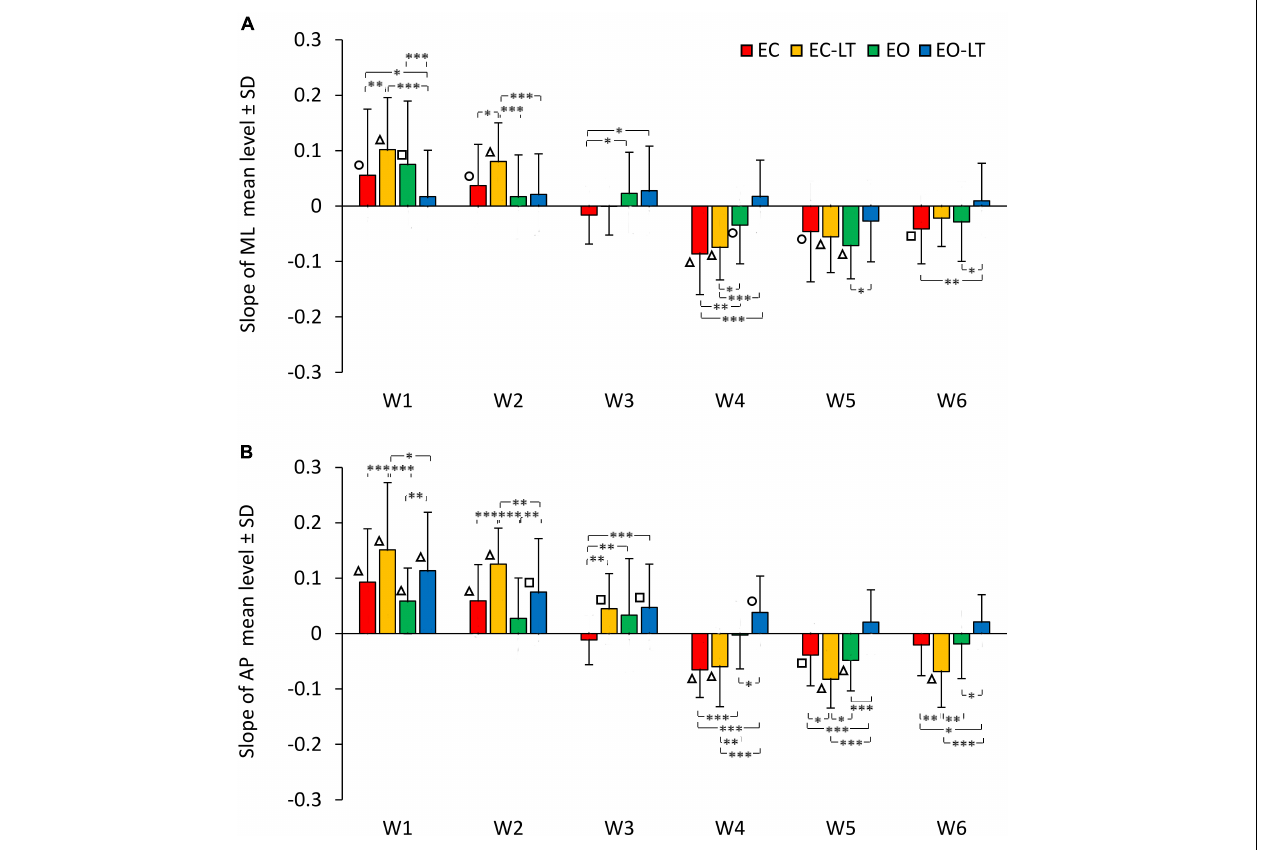
FIGURE 6 | Adaptation rate in the frequency windows (Ws) of ML (A) and AP (B) spectra. The mean slopes of the lines calculated for each frequency window (W) are reported for ML and AP in the different sensory conditions (red, EC; yellow, EC-LT; green, EO; blue, EO-LT). For all sensory conditions, the slopes of W1 and W2 are always positive indicating an increment, during the trial repetition, in the mean level of the spectrum. In W3, the slope is not different from zero in the ML direction for all sensory conditions, while in the AP direction was positive, except for the EC condition, and different from zero only for touch (EC-LT and EO-LT). From W4 to W6, except for the EO-LT condition, the slopes are always negative indicating a reduction in the mean level of the spectrum during the trial repetition. Asterisks indicate significant differences between sensory conditions ( ∗ p < 0.05; ∗∗ p < 0.01; ∗∗∗ p < 0.001). Symbols indicate slopes significantly different from